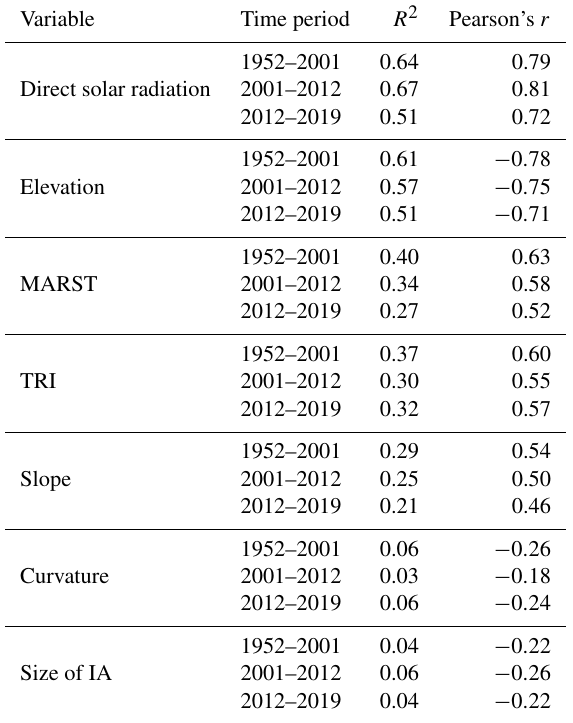
Table 3. Linear regression parameters and correlation metrics for each studied